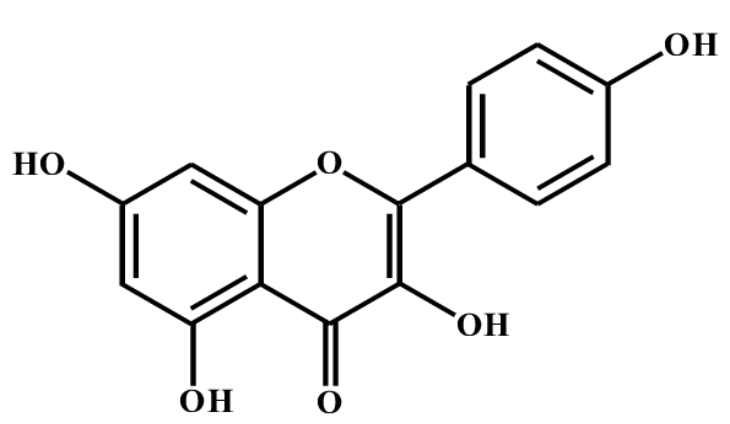
Figure 3. Chemical structure of kaempferol.